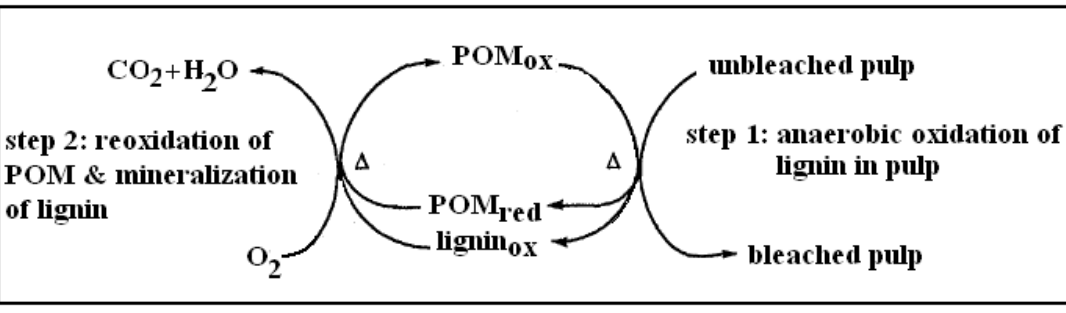
Figure 4. Two steps in POM